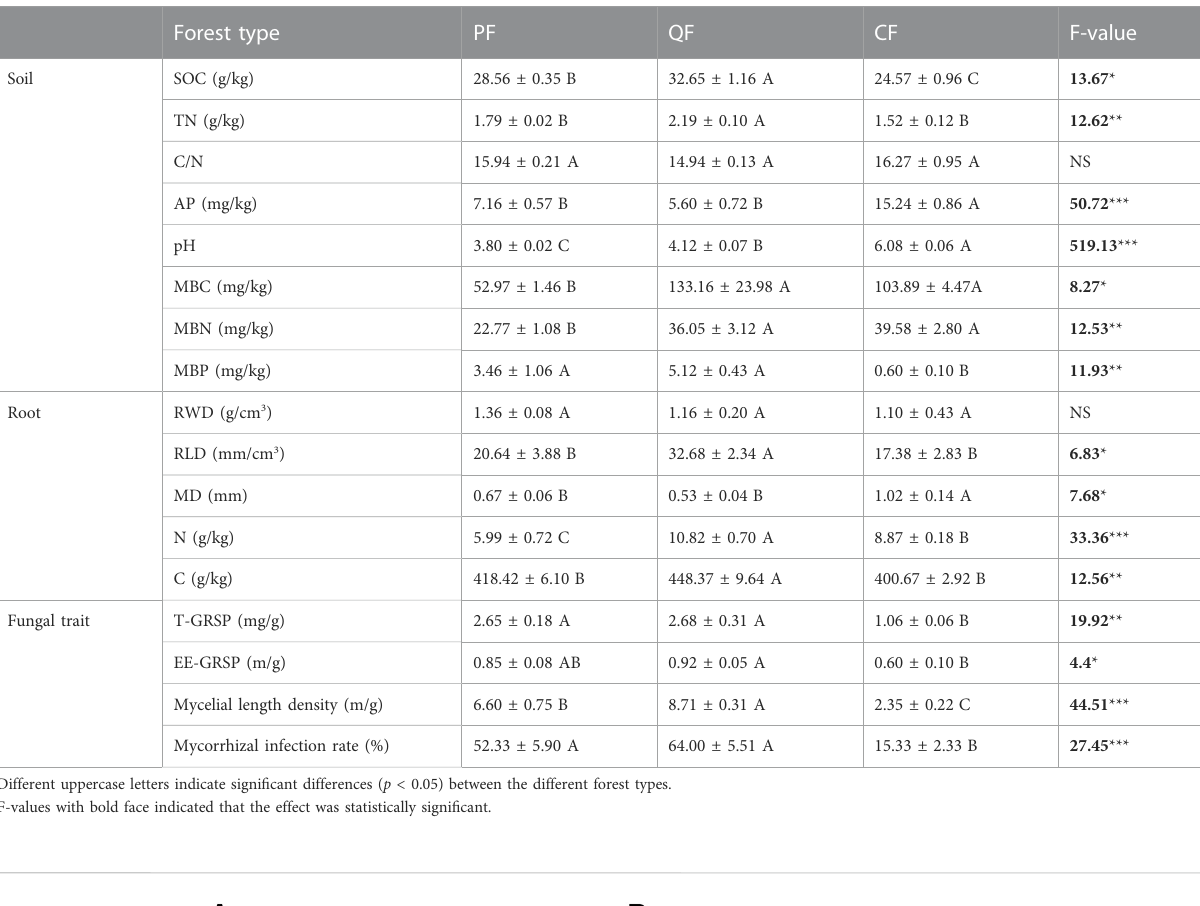
TABLE 1 Soil and fi ne tree root properties and fungal traits at three forest sites (mean ± SE).